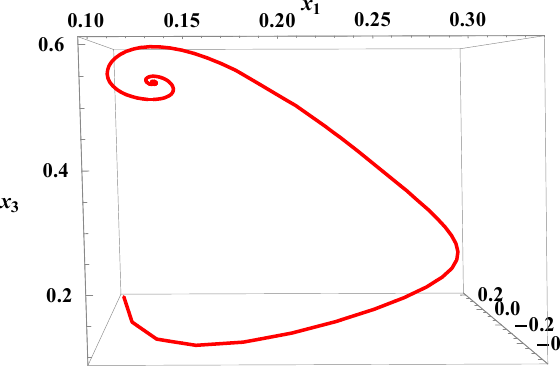
Figure 11. Parametric 3D plot of controlled state vectors.